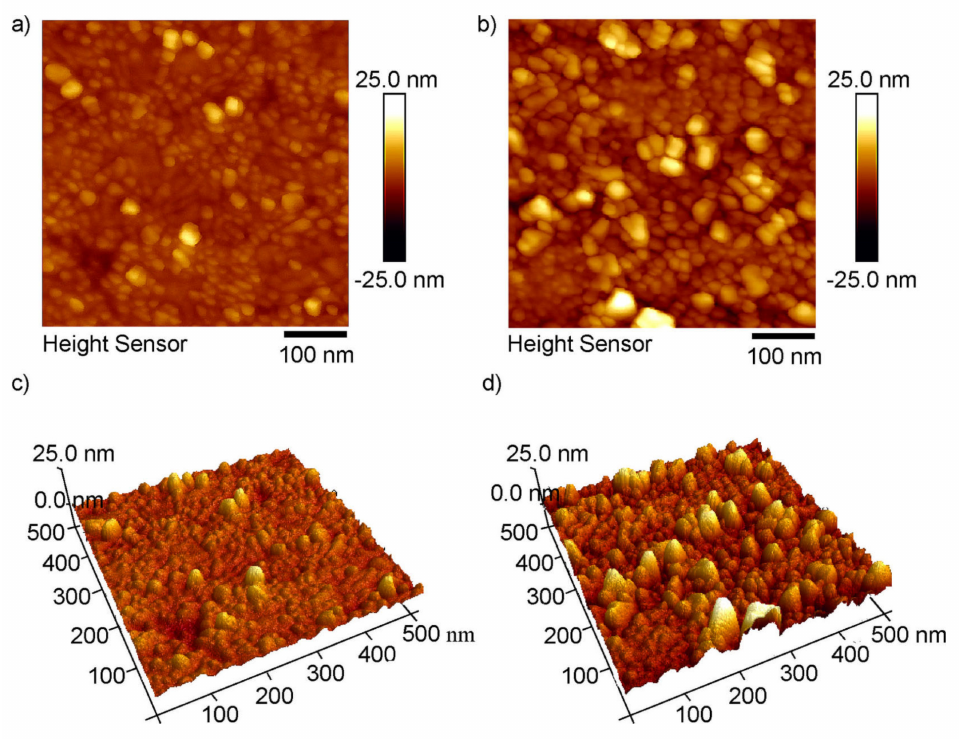
Figure 6. AFM images and corresponding 3D surface visualization of samples S70 ( a , c ) and S75 ( b , d ). On the other hand, the morphology of samples deposited at GLAD angle of 70 di ff erent. A granular-like surface structure is visible confirming columnar growth of the WO 3 thin film. The observed mean sizes of the structures in those samples (vertical vs. horizontal) are 7.0(3.5) vs. 19.6(4.1) and 13.6(4.9) vs. 24.0(5.5), for S70 and S75, respectively. Standard deviations are given